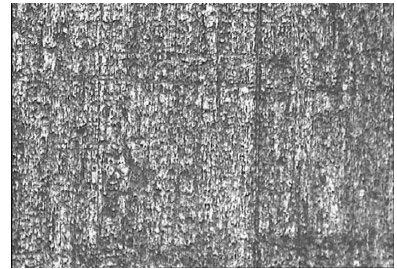
Figure 4 (a): -Mild steel sample blank kept in 1 M HCl for 24 hours at 35 0 C.